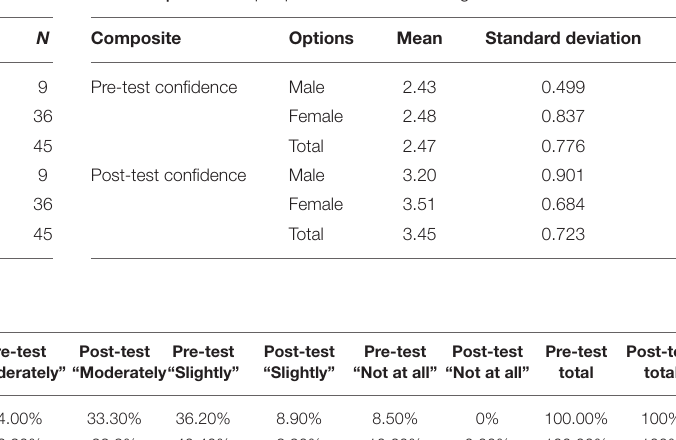
TABLE 2 | Means for pre/post-test knowledge & gender. TABLE 4 | Means for pre/post-test confidence & gender.